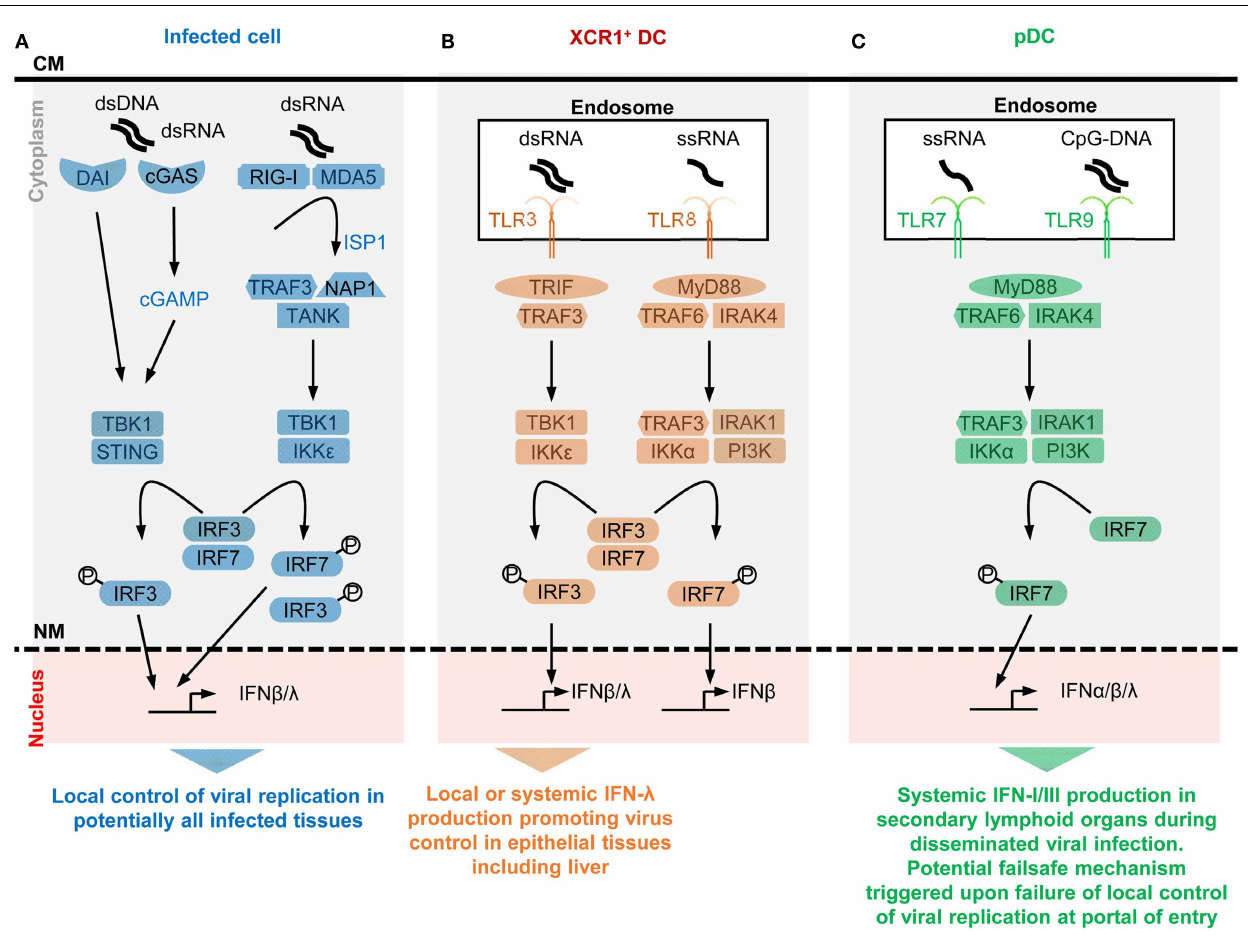
tissues. Since XCR1 + DCs are especially efficient at producing IFN-III upon HCV stimulation, they might contribute to local or systemic IFN production during infection with this virus, to promote IFN- λ -mediated protection of hepatocytes. Uninfected XCR1 + DCs and other uninfected cells may produce some IFN- β upon engulfment of materials containing ssRNA and the consecutive triggering ofTLR8 in endosomes.The contribution of this pathway to anti-viral defense is not well understood yet, in part because mouseTLR8 is deficient for this function. (C) Uninfected pDCs selectively produce high levels of all subsets of IFNs upon engulfment of materials containing ssRNA or CpG DNA and the consecutive triggering ofTLR7/9 in endosomes. However, pDCs seem to be activated for this function only in lymphoid tissues. Hence, pDC might contribute to systemic IFN production during blood-borne viral infections or as a failsafe mechanism activated upon abnormal widespread dissemination of a viral infection once it has escaped local confinement at its portal of entry. CM, cell membrane; NM, nuclear